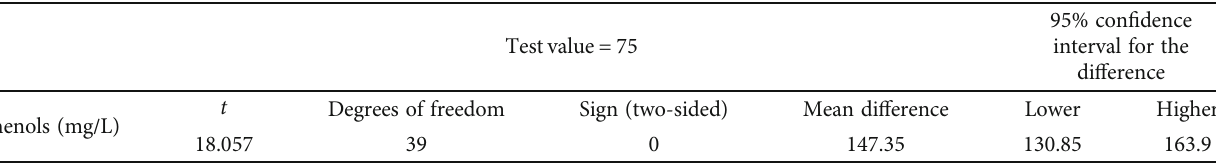
Table 2: Test for a sample.